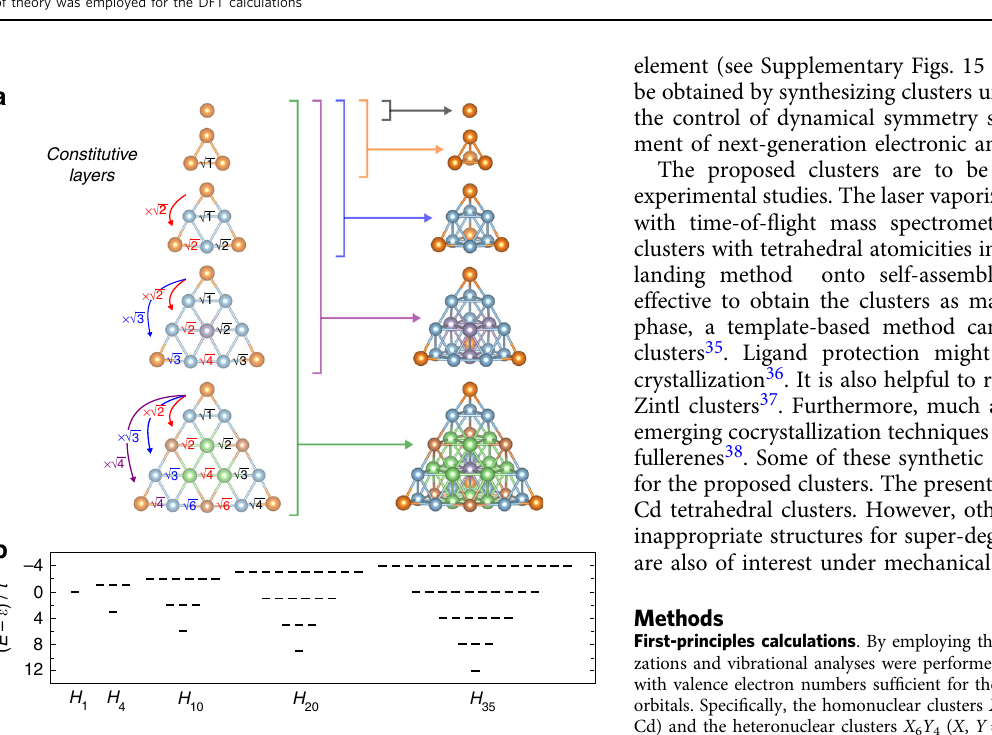
Fig. 4 The tight-binding model analyses for tetrahedral clusters with various sizes. a Ratios of transfer integrals giving rise to the anomalous degeneracy, in which a square-root mathematical sequence appears. b Energy spectra of the tight-binding models under the degeneracy conditions. Here, t denotes a transfer integral whose absolute value is the smallest in each